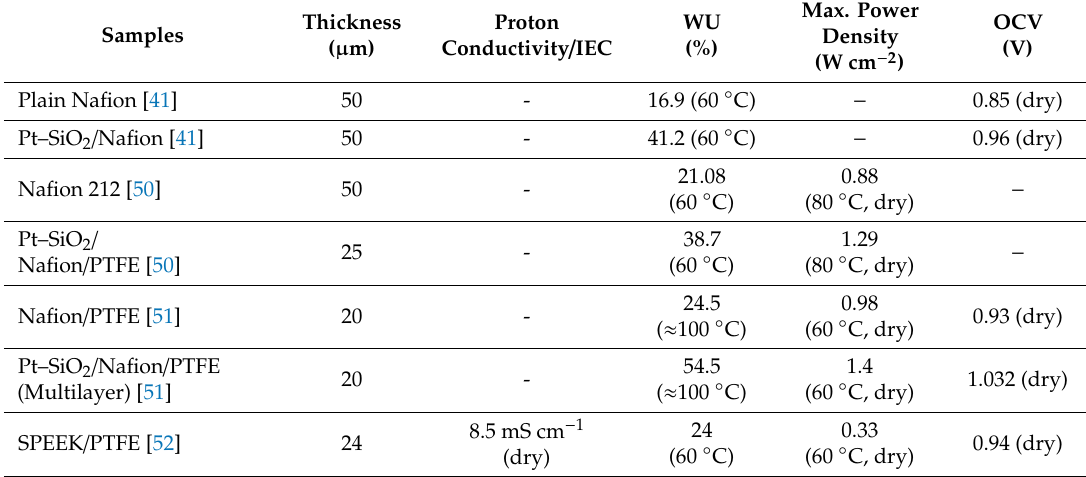
Table 1. A summary of the main contributions about self-humidifying PEMs for PEFC application.